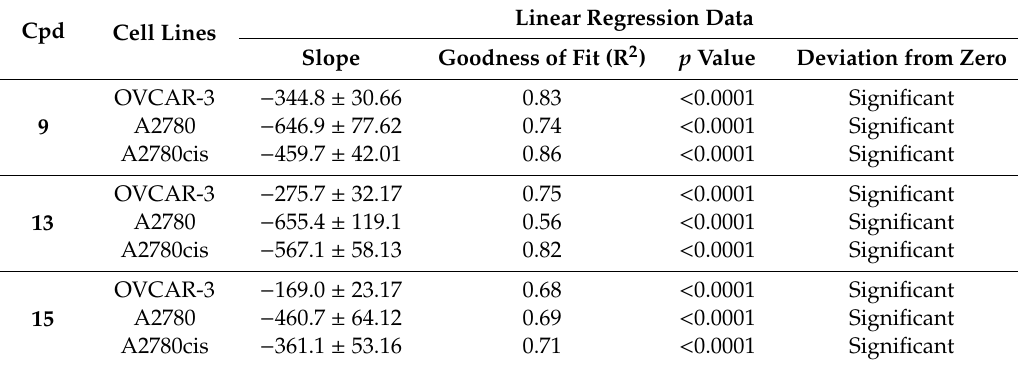
Table 5. The capacities of 9, 13 and 15 compounds to reduce the metabolic potential of treated ovarian tumor cells in vitro, quantified through the mathematic parameter hillslope, derived from the linear regression of the dose–response relationship (concentration of compounds versus fluorescence intensity).